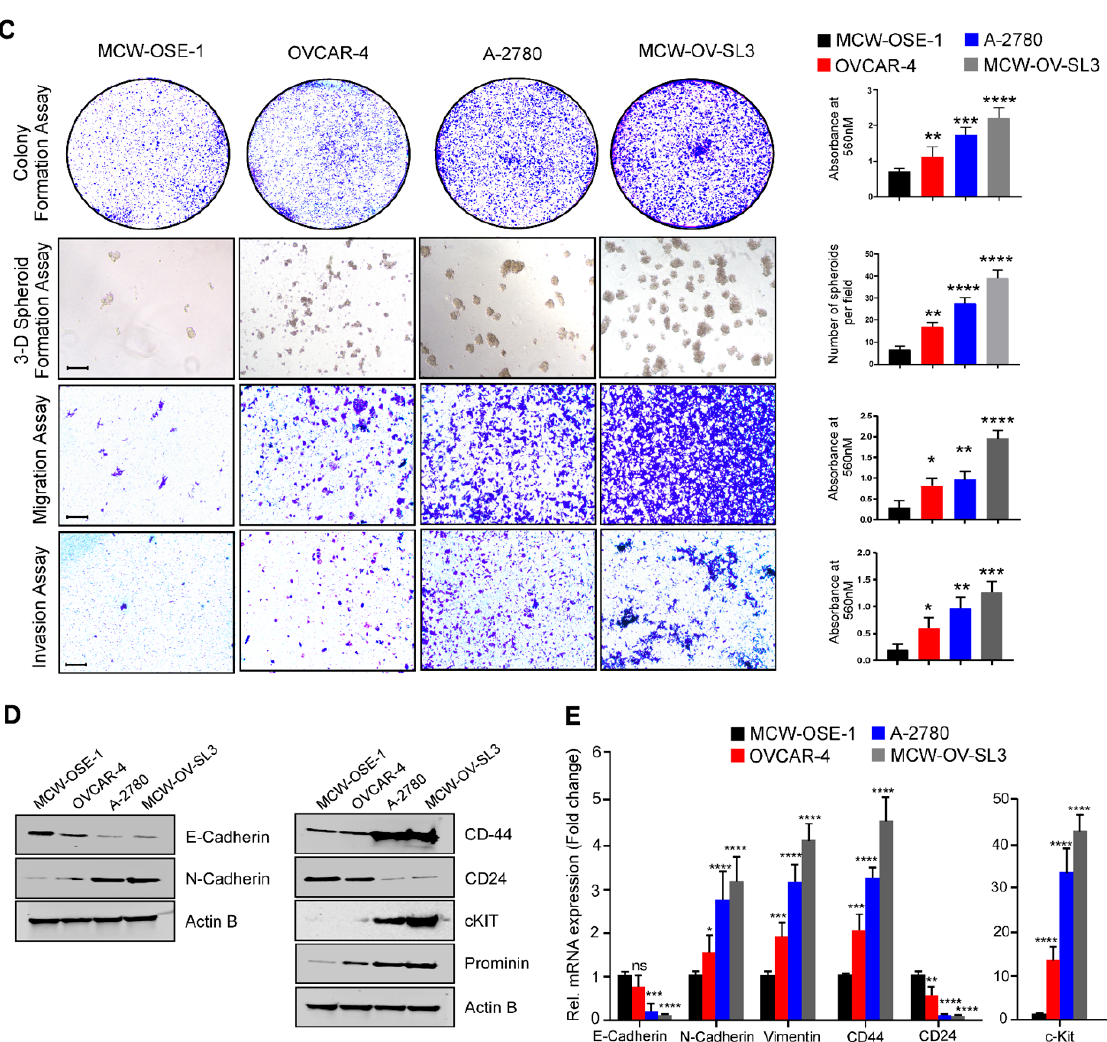
Figure 2. MCW-OV-SL3 cell line exhibits oncogenic characteristics similar to the aggressive type of ovarian cancer cells. ( A ) MCW-OSE-1, MCW-OV-SL3, and the cell lines indicated were grown on 96-well culture plates for indicated periods and the cell proliferation was assessed using manual counting. ( B ) Cell lines were grown on 6-well culture plates for 14 days for colony formation, then stained using 0.5% crystal violet and photographed. For 3D formation assay, cells were grown on Matrigel-coated plates for seven days and then photographed using phase-contrast microscope. Spheroids were counted from five separate fields and quantitated (right panel). For cell migration and invasion, cells were plated on trans-well inserts with or without Matrigel for 12 h. Migrated or invaded cells were photographed (left panel). Scale bars represent 500 µ m. The bar graph on the right indicates the quantification of crystal violet stain eluted from the cell colonies or from migrated or invaded cells. Columns indicate mean ( n = 3) ± SE * p < 0.05, ** p < 0.01, *** p < 0.001, **** p < 0.0001 statistically significant compared with normal cell line (MCW-OSE-1). ( C ) Representative images of three microscopic fields in a wound-healing assay of MCW-OV-SL3 cells with other indicated cell lines cells were captured at indicated time points. Red line indicates the empty space between healing cells. Scale bars represent 500 µ m. ( D ) Protein lysates were prepared from indicated ovarian cancer cell lines and immunoblotted using indicated antibodies (see Figure S3). ( E ) Total RNA was isolated from indicated cell lines and qPCR was performed to determine the expression of the indicated genes. All mRNA expression was normalized to β -actin in qPCR assays. Histograms represent mean ± SE of triplicate determinations. Statistical analysis was undertaken using Student’s t -test. * p < 0.05, ** p < 0.01, *** p < 0.001, **** p < 0.0001, ns: